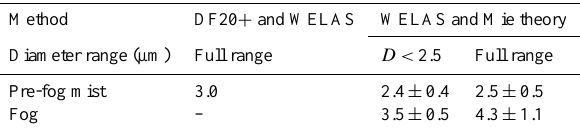
Table 5. Averaged values of the aerosol extinction cross section (10 − 8 cm 2 ) computed by two methods, for different size intervals, and for both pre-fog mist and fog. The method “DF20 + and WE- LAS” means the slope is computed between pec K and N ha . The method “WELAS and Mie theory” means that pec M is divided by N ha